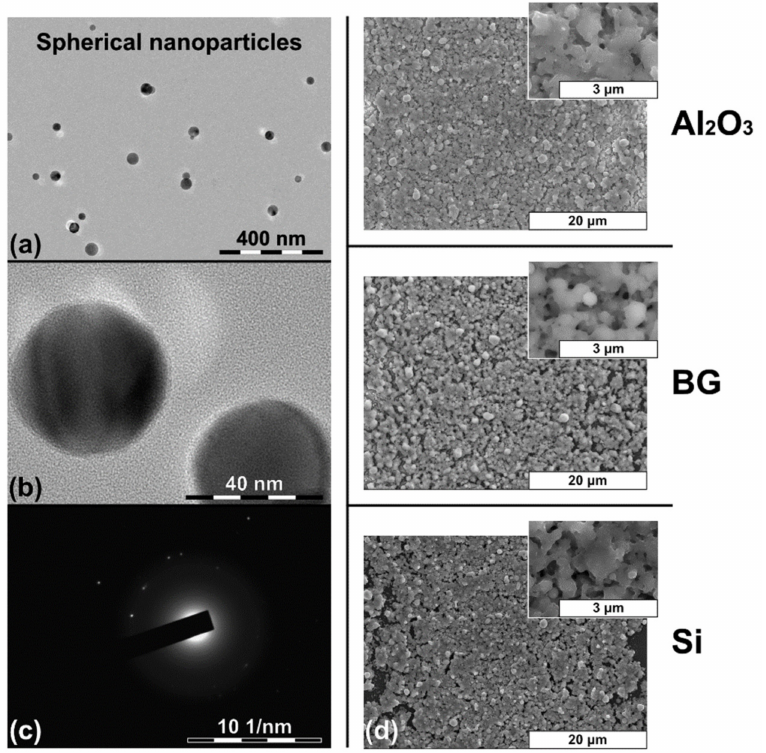
Figure 7. ( a , b ) TEM image of spherical nanoparticles obtained during heat treatment of agglomerates; and ( c ) corresponding electron diffraction pattern. ( d ) SEM images of printed lines of spherical nanopar- ticles on Al 2 O 3 , BG, and Si substrates sintered in a reducing hydrogen atmosphere at T sint = 550 ◦